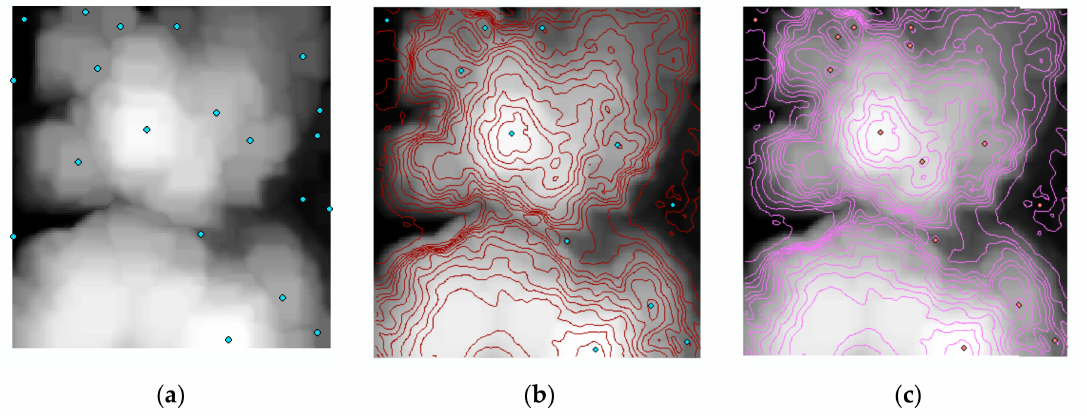
Figure 30. Distribution maps extracted by the traditional Mountain Vertices Extraction Methods using the sixth dataset.